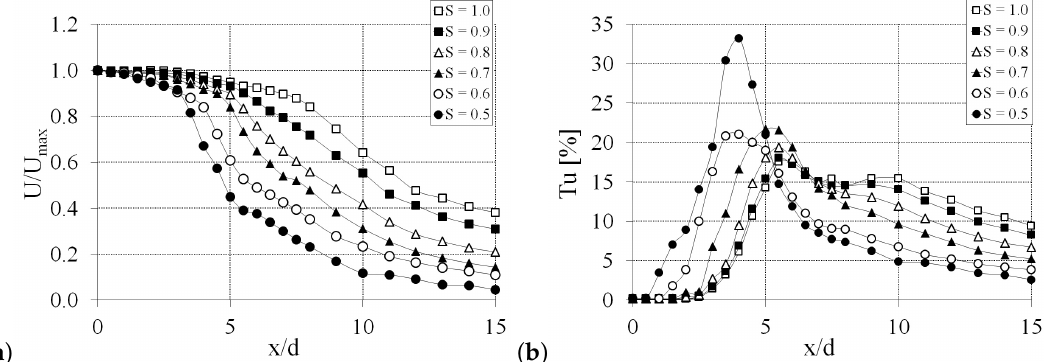
Figure 4. ( a ) Mean and ( b ) fluctuating velocity profiles along the jet axis, L / D = 7, Re = 10,000.